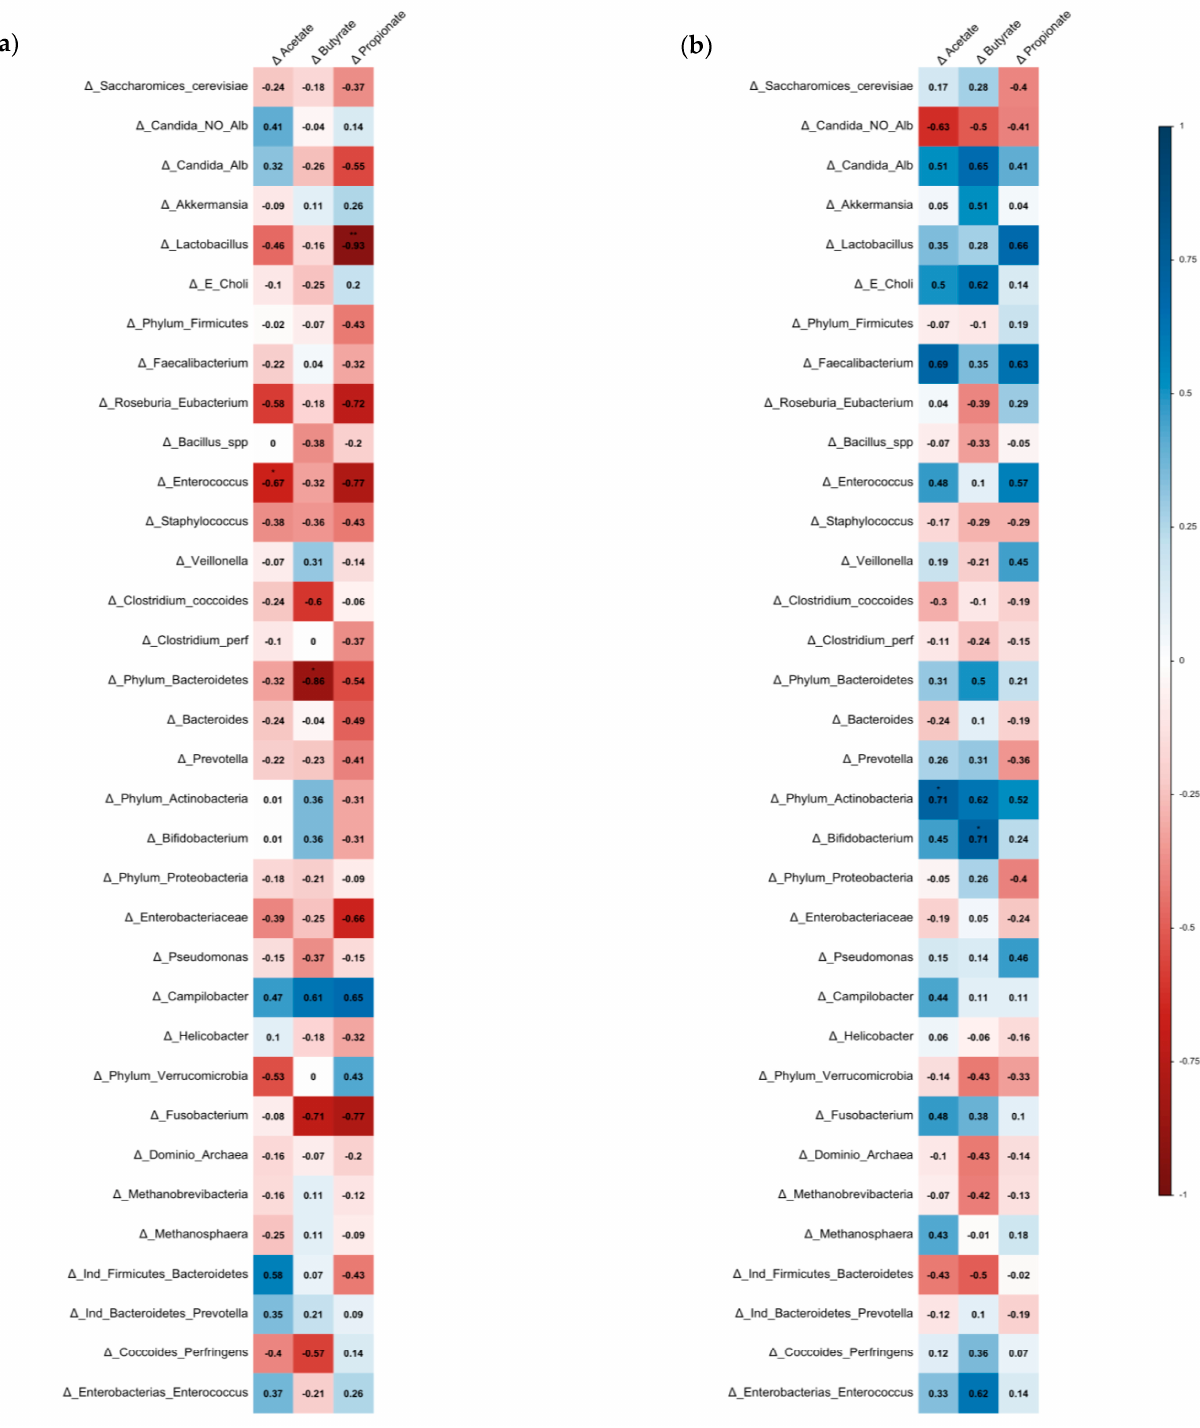
Figure 4. Correlation between SCFAs and changes of microbiota in treated-obese patients. Spearman’s matrix correlations between differential SCFA levels and variations in abundance of specific gut bacteria after ( a ) PENS-Diet or ( b ) PENS-Diet+Prob. The color scale indicated the lower ( − 1; red) and the higher (1; blue) Rho values. * p < 0.05 and ** p < 0.01.